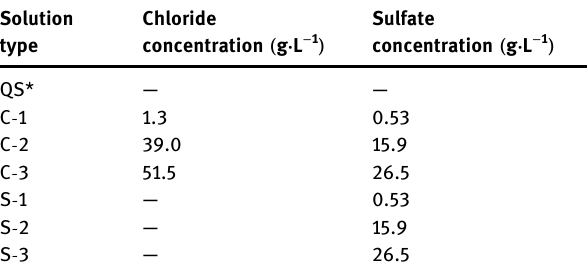
Table 7: Working conditions of concrete specimens Solution type